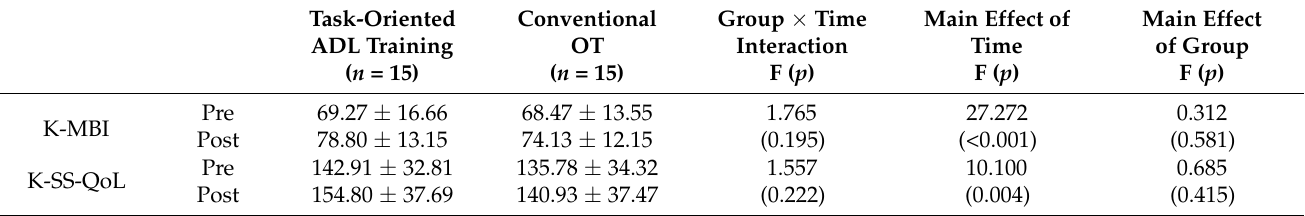
Table 4. Secondary outcome variables before and after the interventions between the groups ( n =